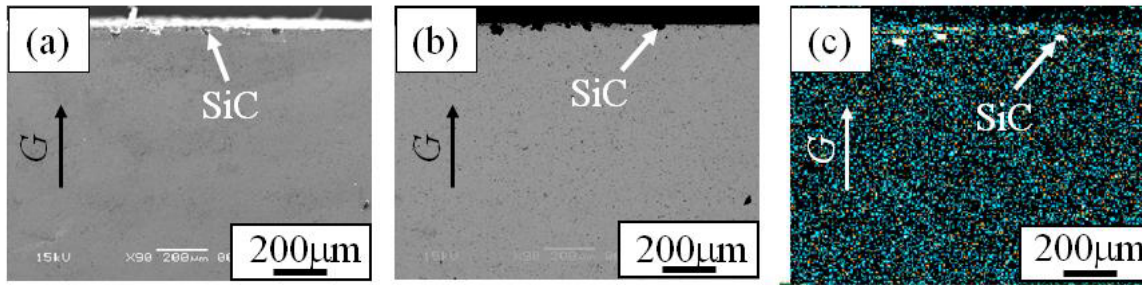
Figure 8. Microstructures of the cross-section of Specimens 2. (a) SE Image, (b) Compo Image and (c) Si distribution map by EDX [17].